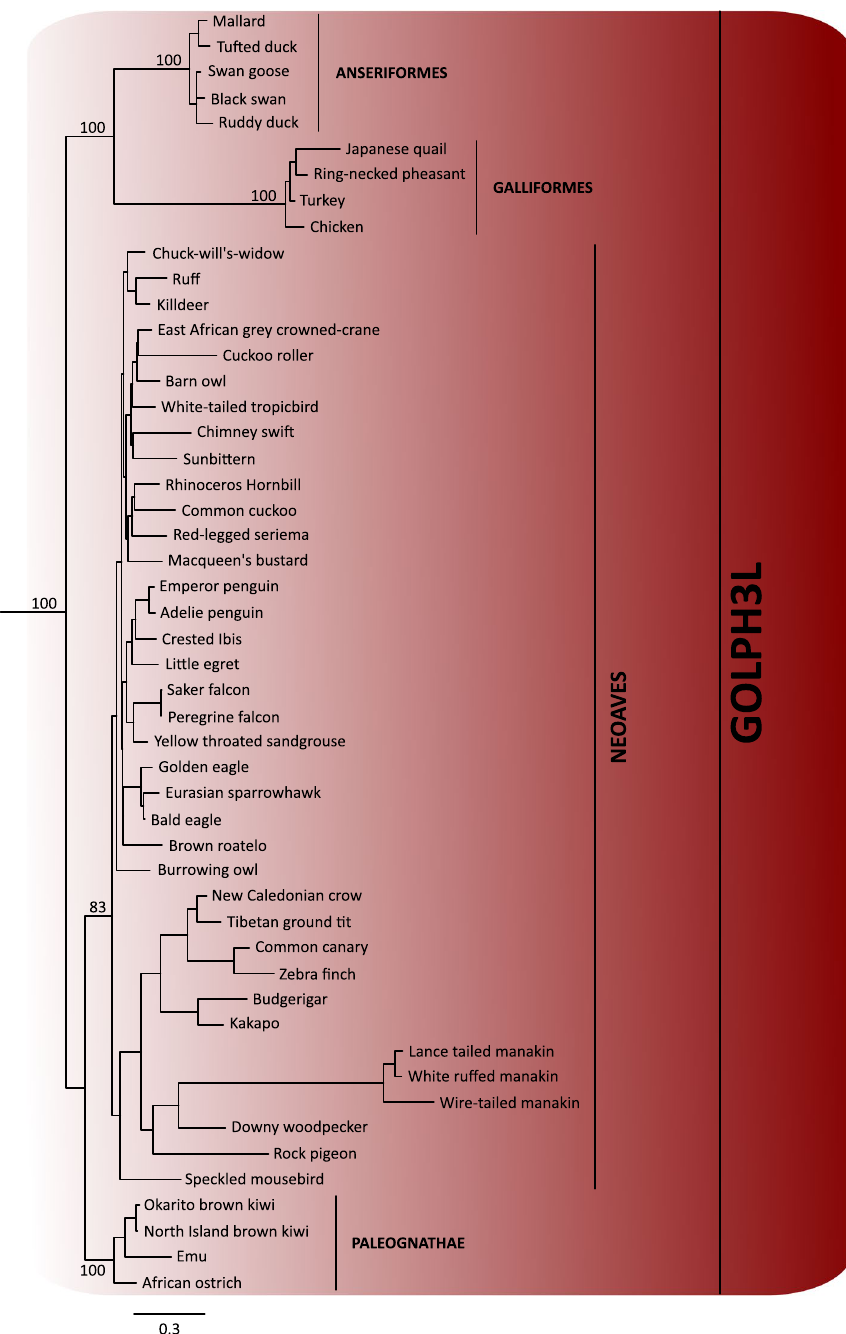
Figure 7. Maximum likelihood tree showing sister group relationships among GOLPH3L genes of birds. Numbers above the nodes correspond to support values from the ultrafast bootstrap routine. GOLPH3L sequences from crocodiles and turtles were used as outgroups (not shown). The scale denotes substitutions per